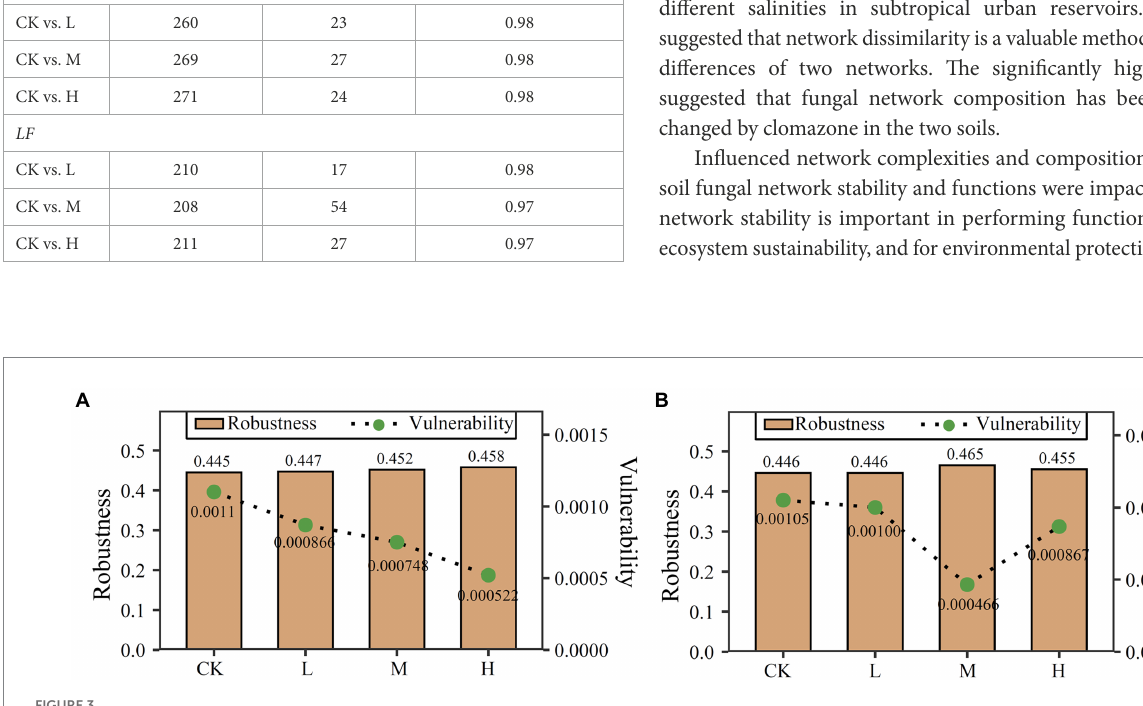
TABLE 2 Numbers of shared nodes and edges and their dissimilarity between control and each clomazone treatment in JSJ and LF soils. Shared Shared nodes edges